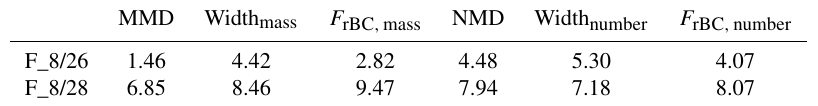
Table 2. Variations of the parameters derived from time-resolved lognormal fits to single-particle rBC data measured during F_8/26 and F_8/28. Variations are determined as relative standard deviations (RSDs, in percentage).